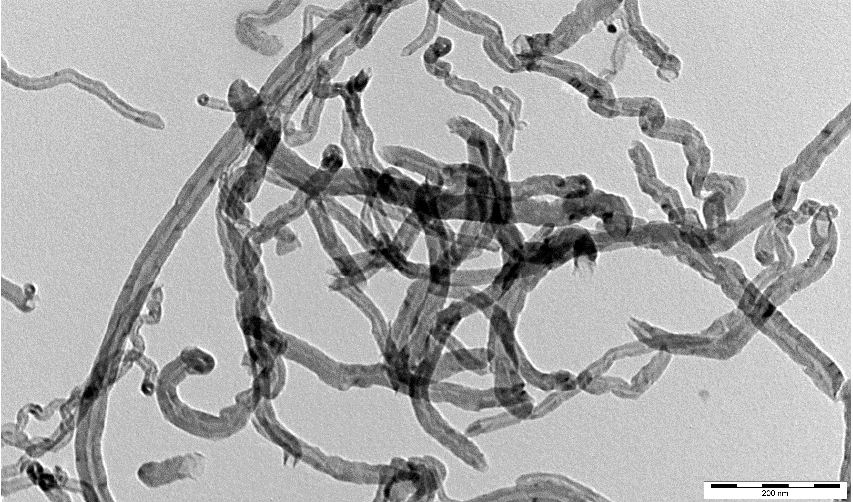
Figure 6. TEM image of MWCNTs. Bar = 200 nm.